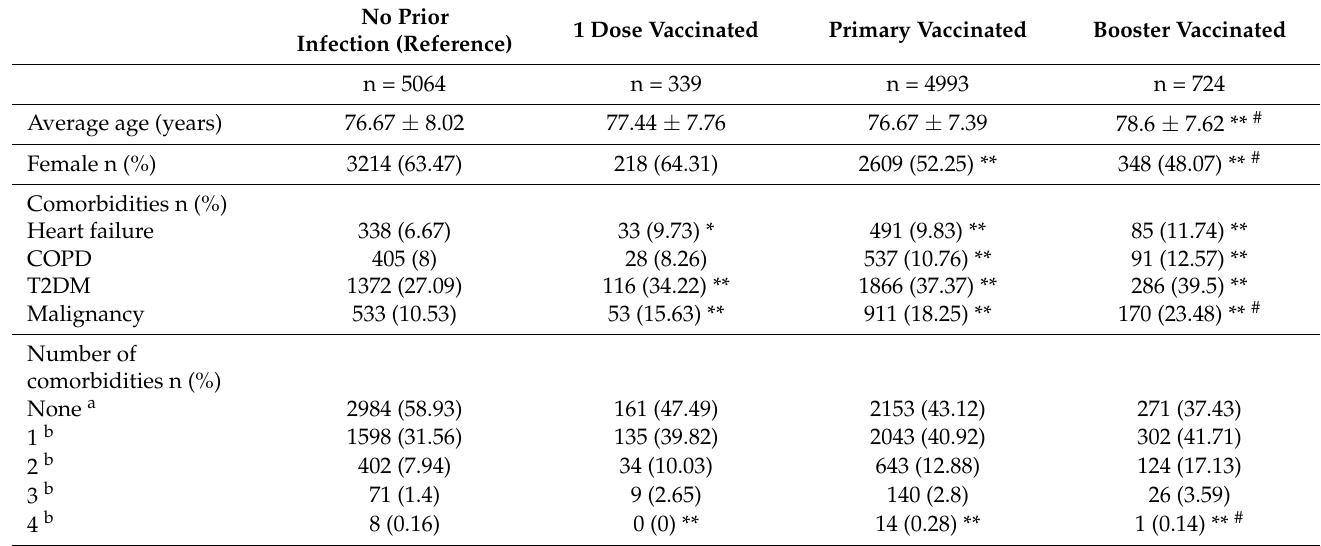
Table 3. Characteristics of SARS-CoV-2 delta VOC hospitalized patients.